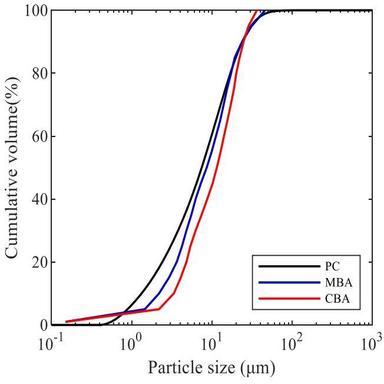
Particle size distribution of PC and treated BA samples.